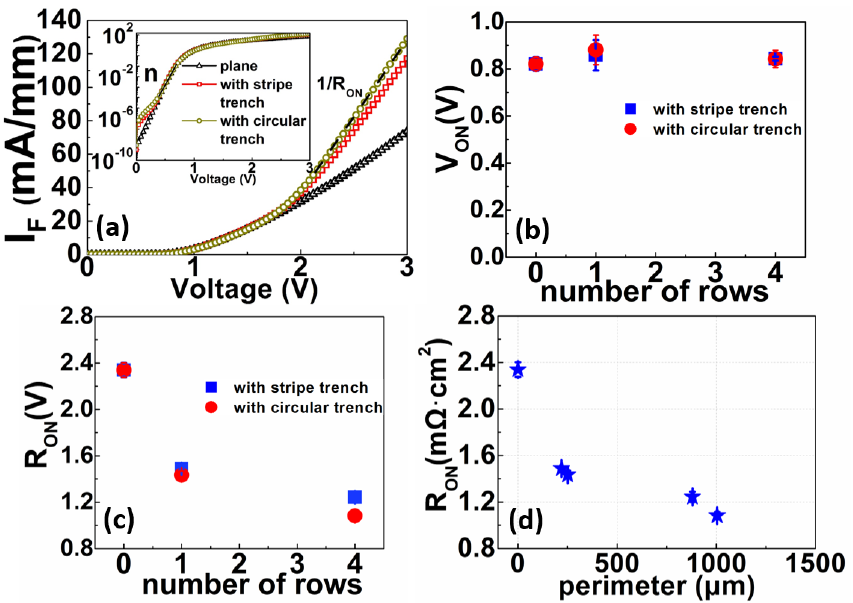
Figure 3. ( a ) the forward characteristics of the SBDs with three different anode geometries (with four rows of circular anode trenches and L AC =10 μm). Inset: log scale of the forward-bias regime. The dash line in ( a ) illustrates the definition of R ON used in this letter; ( b ) the V ON (I F =1 mA/mm) of SBDs with three different anode geometries vs. number of rows. (The conventional plane has 0 rows of anode trenches); ( c ) the R ON of SBDs with different anode geometries vs. number of rows; ( d ) the R ON of SBDs with different perimeters of anode trenches (The perimeter of the conventional plane is 0 μm).